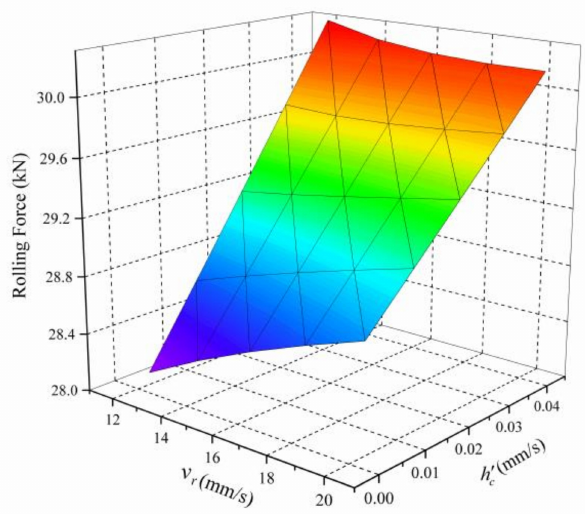
Figure 10. The influence of rolling velocity and roll gap reduction velocity on rolling force (2 h 1 = 1.57